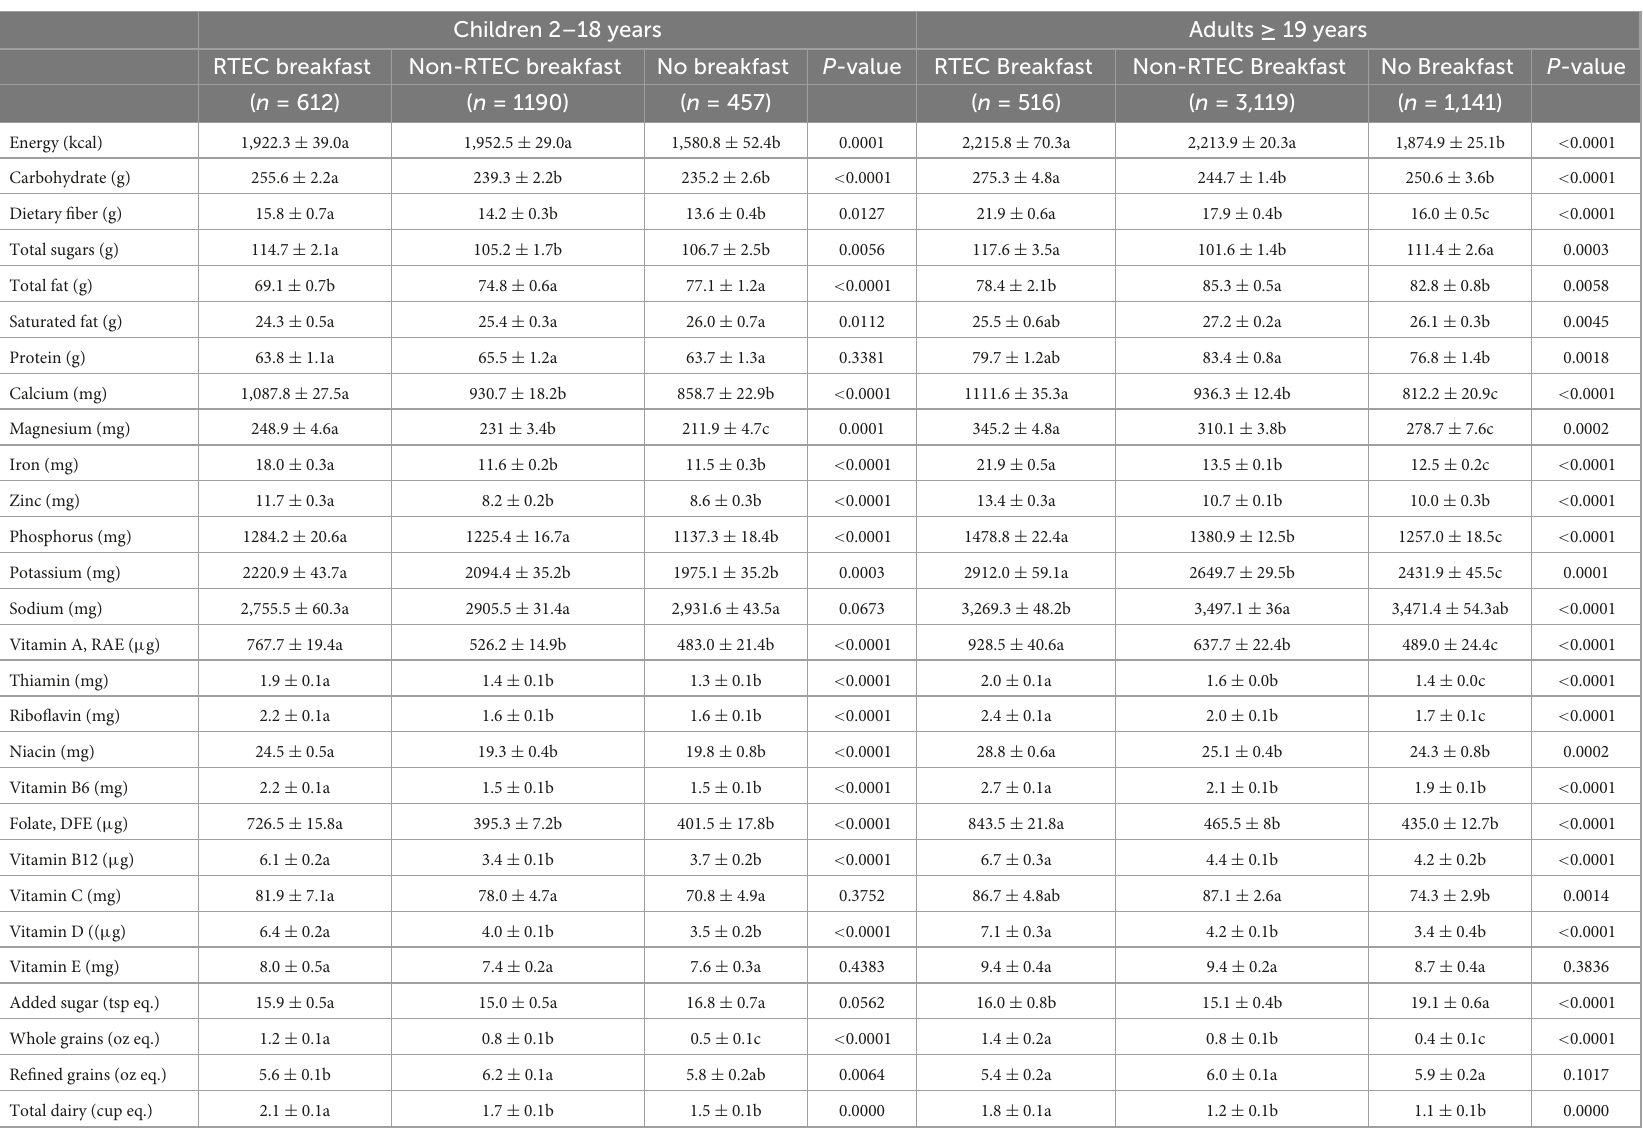
TABLE 2 Adjusted daily intake of energy, nutrients and food groups in US children and adults by breakfast status, National Health and Nutrition Examination Survey, 2017 –